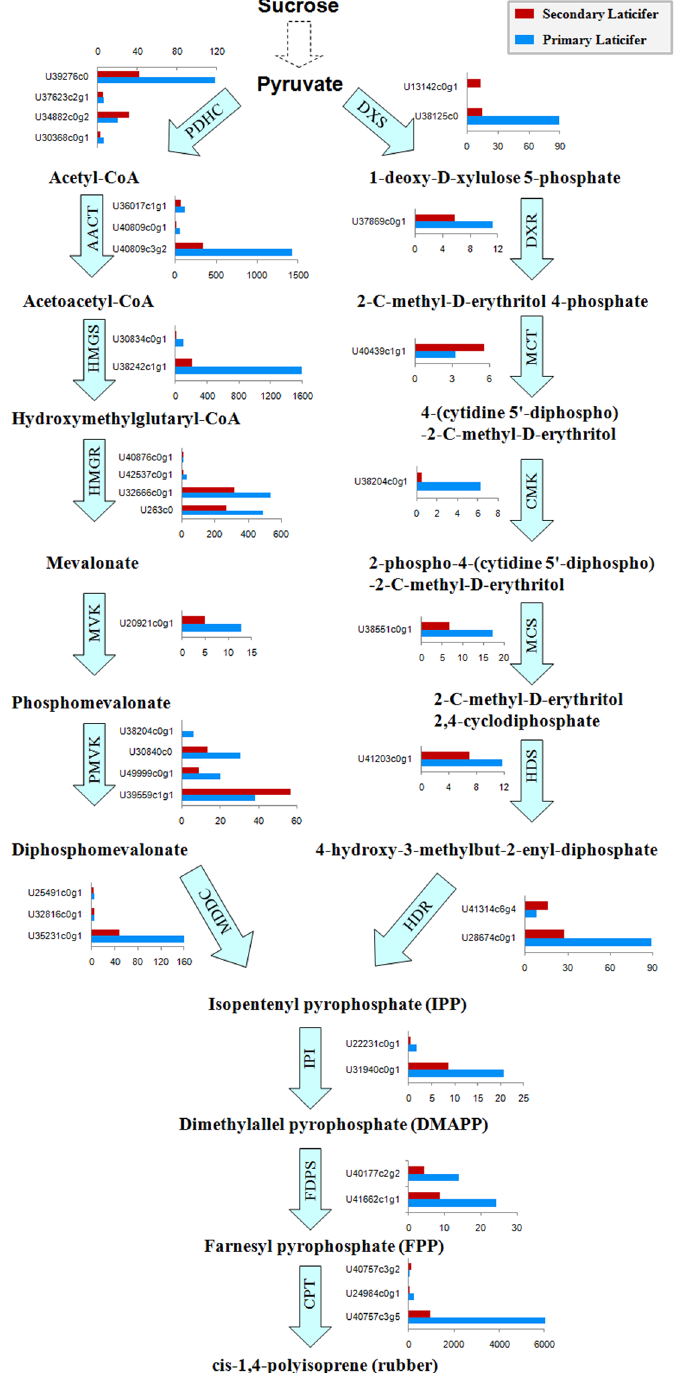
Figure 6. The rubber biosynthesis pathways and genes involved. The expression levels of each unigene in TPM are presented beside the